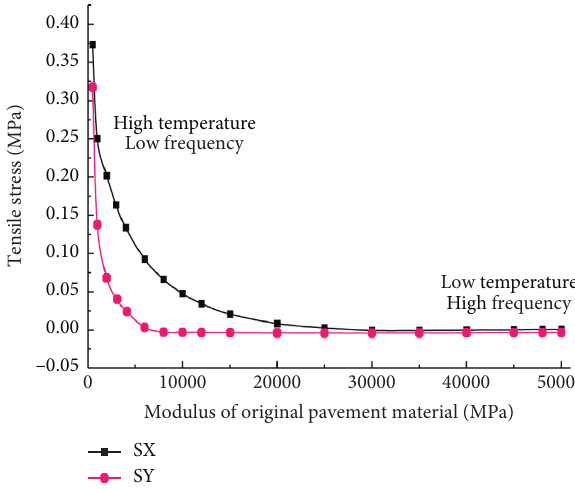
Figure 25: The effect of original pavement material modulus on tensile stress of joint filling